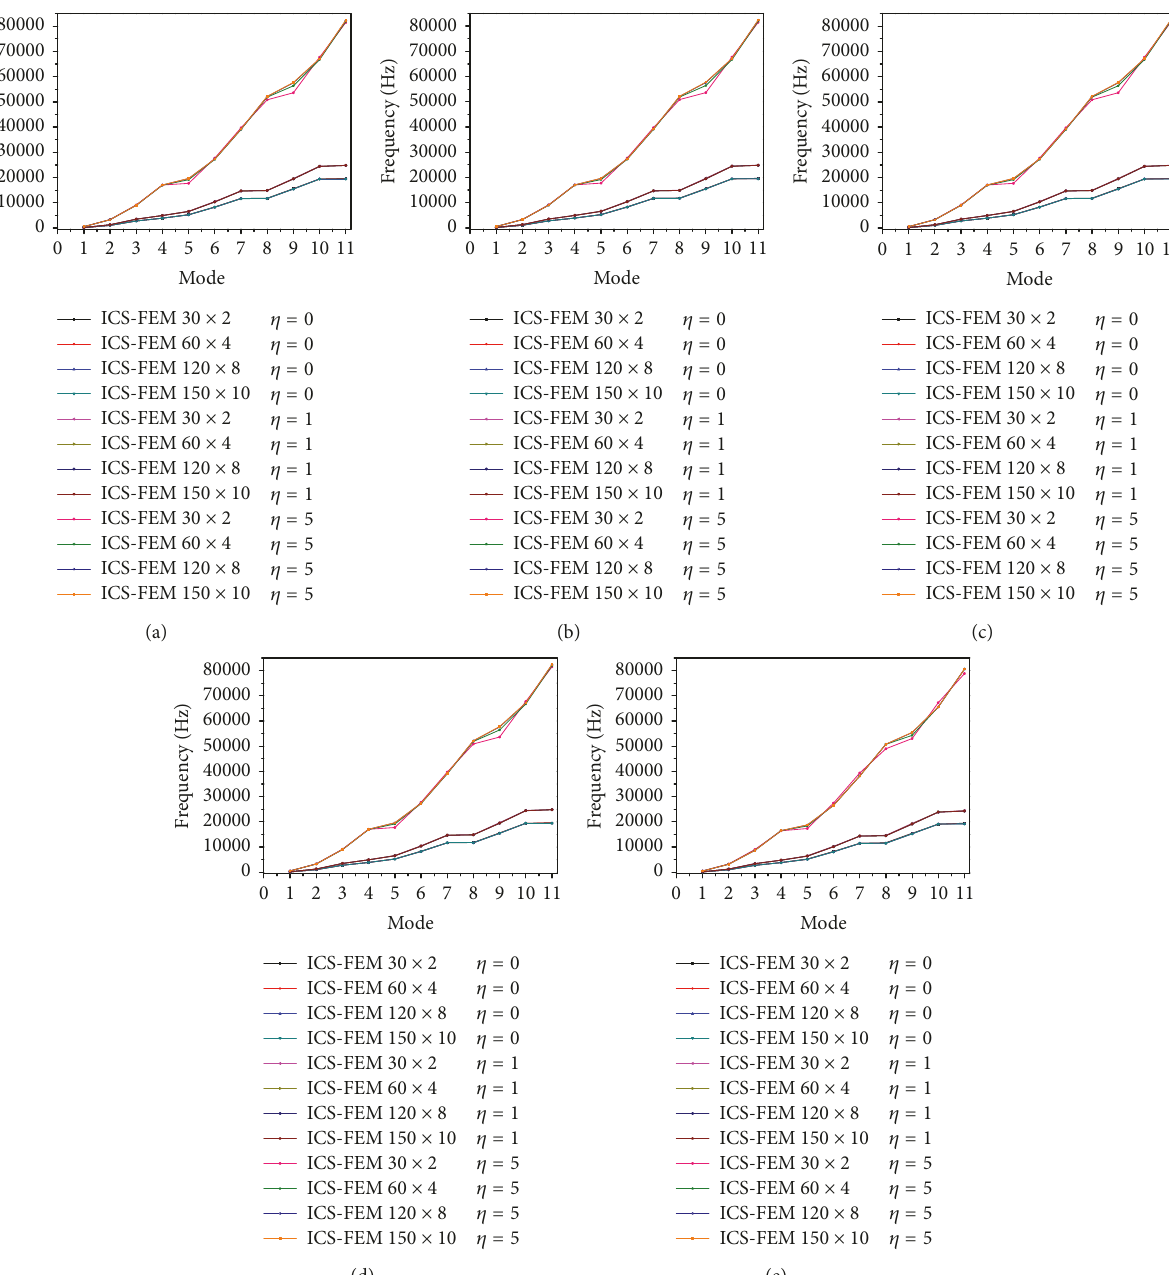
; (d) 𝑓 eq ΦΦ ; (e) 𝑓 eq ΨΨ of clamp-free BaTiO 3 –CoFe 2 O 4 FGMEE - re